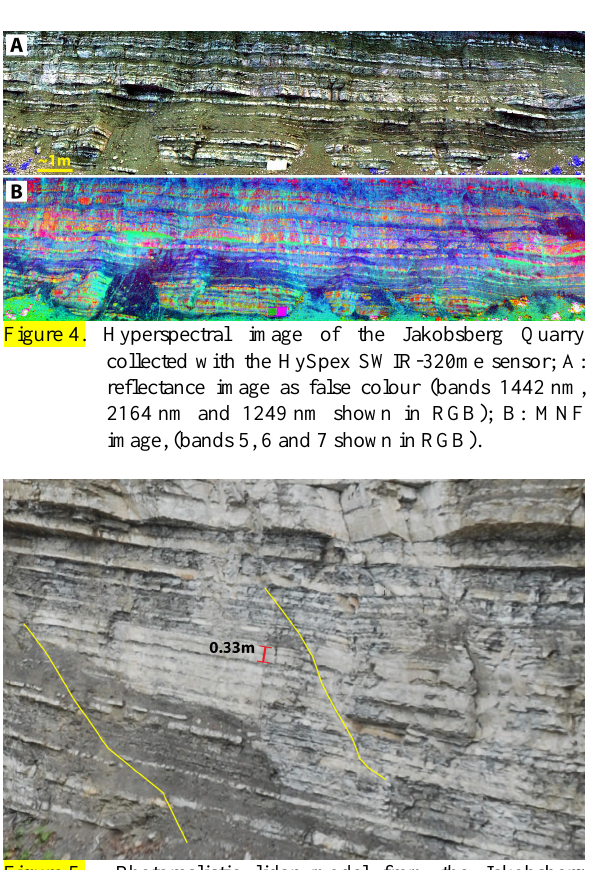
Figure 5. Photorealistic lidar model from the Jakobsberg Quarry with fault mapping (yellow lines) and thickness measurement of one carbonate layer